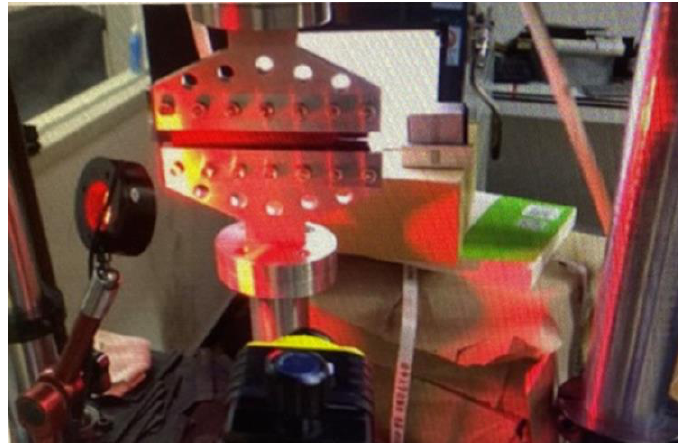
Figure 7. The setup of the fatigue crack propagation experiment.